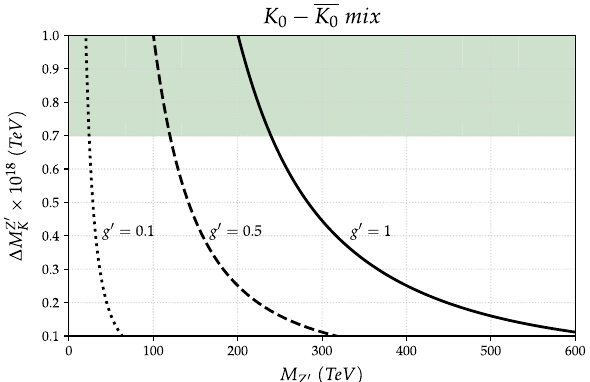
Fig. 4 Bounds to the neutral gauge boson mass M Z (cid:2) of Model D9 due to K 0 − ¯ K 0 mixing effects. The vertical axis displays Z (cid:2) contributions ( (cid:8) M Z (cid:2) ) to the mass split of the neutral Kaon system. Dotted, dashed K and solid black curves correspond to gauge coupling values: g (cid:2) = 0 . 1, 0 . 5 and 1 respectively. The shaded region is excluded due the constrain (cid:8) M NP < 0 . 2 (cid:8) M exp K